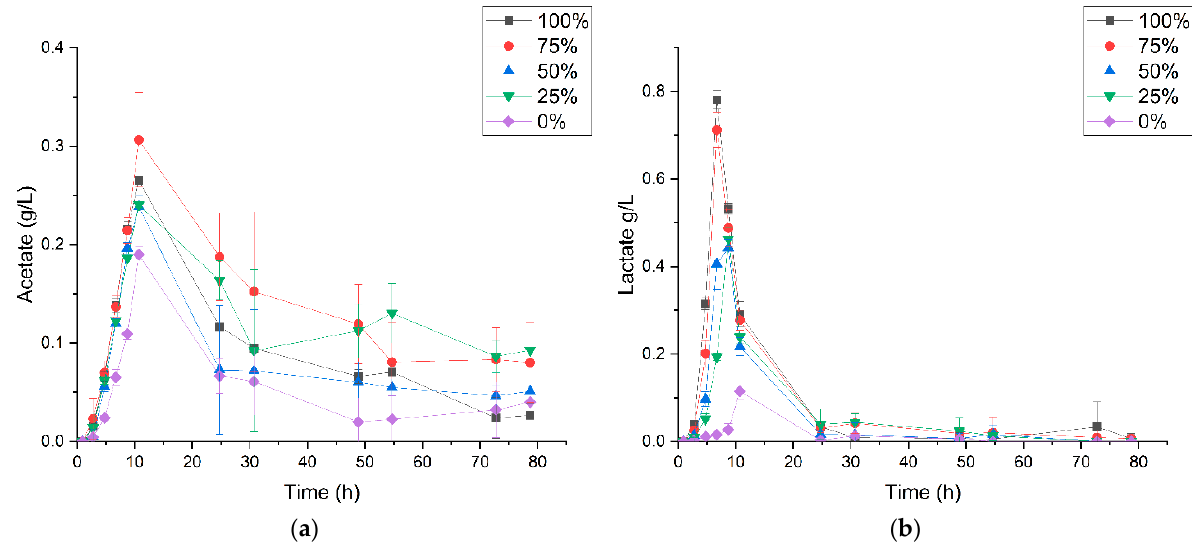
Microorganisms 2021 , 9 , x FOR PEER REVIEW